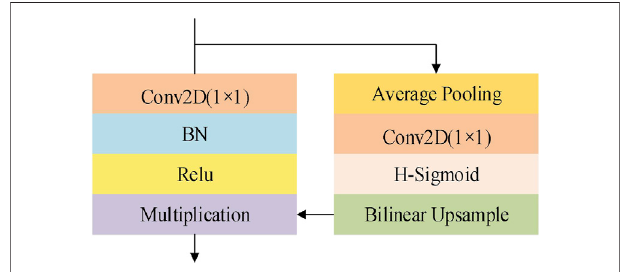
FIGURE 3 | The structure of Lite R-ASPP. H-Sigmoid stands for the Hard Sigmoid function.